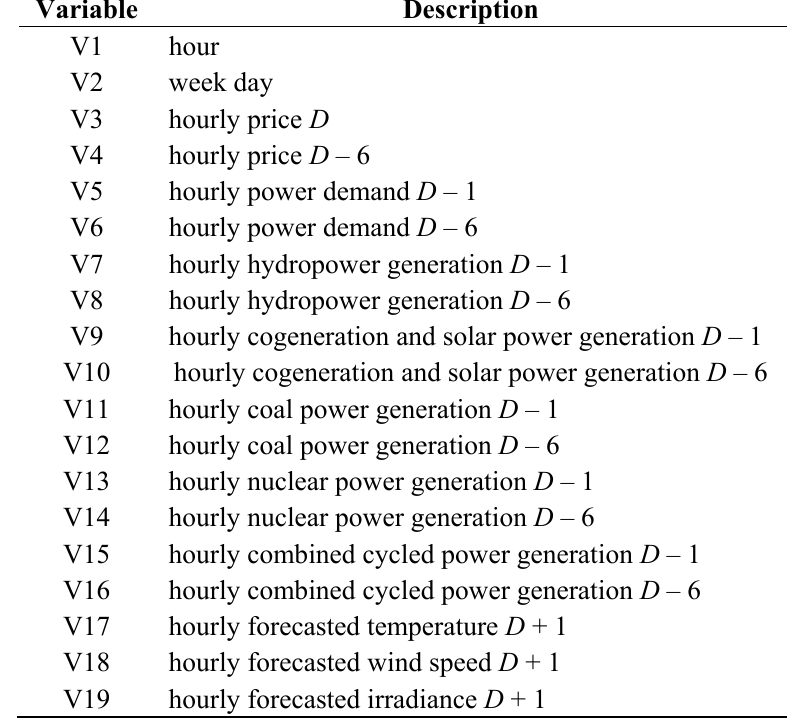
Table 3. Explanatory variables of the explanatory model for price forecast (EMPF) model.